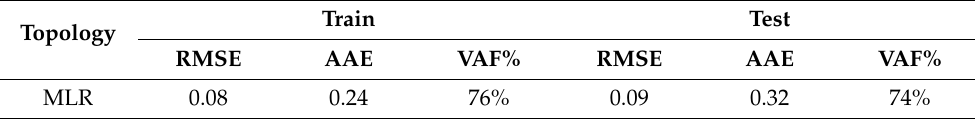
Table 15. Statistical metrics resulting from MLR